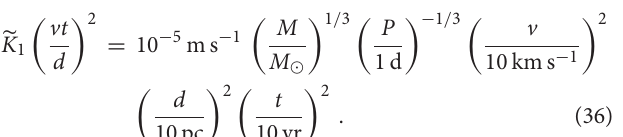
FIGURE 2 | Effect of proper motion on the transit planet GJ 436b. The solid line and left axis show the difference in the duration of transit, while the dashed line and right axis show the second-order